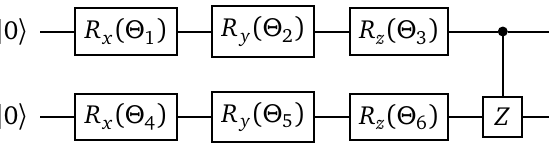
rotation with randomized 3